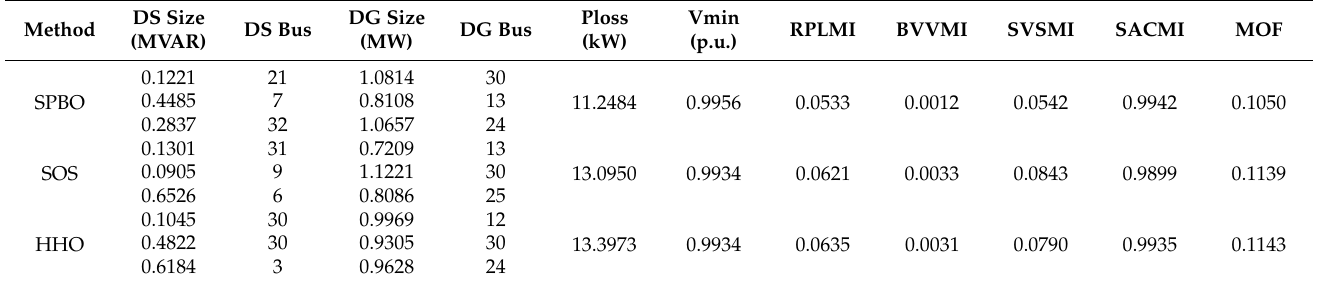
Table 11. Comparison of results for simultaneous DS and GT-DG allocation (case-6) for 33-bus test system.